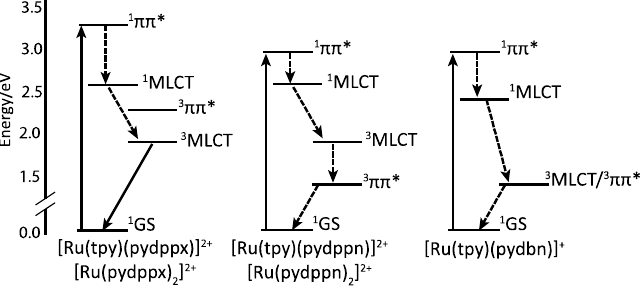
Figure 16. Jablonski diagrams for various ruthenium complexes [118].